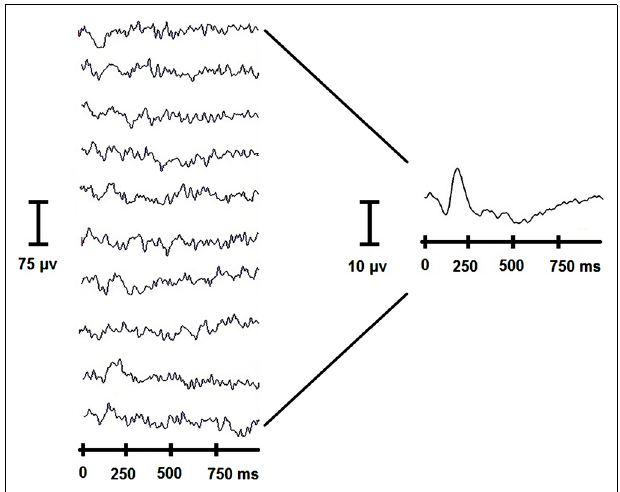
FIGURE 2 | Loss of information as a result of traditional linear analysis of the EEG. The variation between individual trials (at left) is lost as a result of the averaging procedure, as evident in the averaged waveform (at